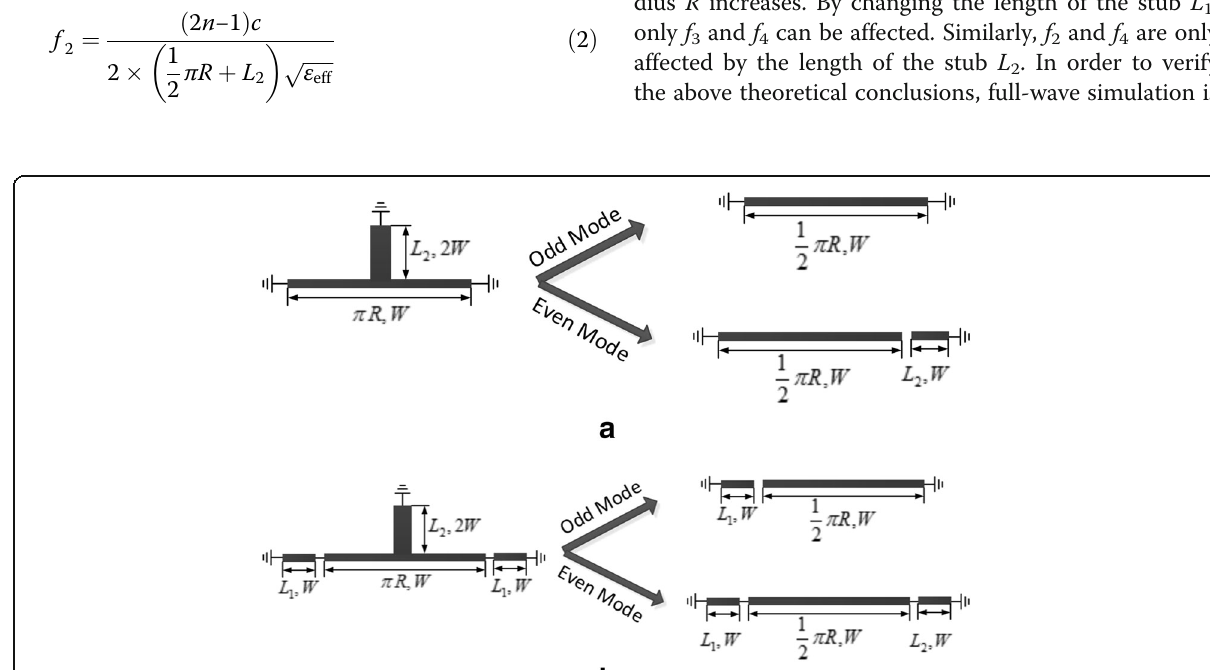
Fig. 2 a The odd- and even-mode equivalent circuits of the odd-mode equivalent circuit. b The odd- and even-mode equivalent circuits of the even-mode equivalent